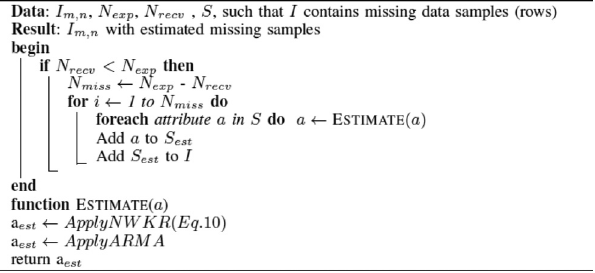
Figure 1. Data samples